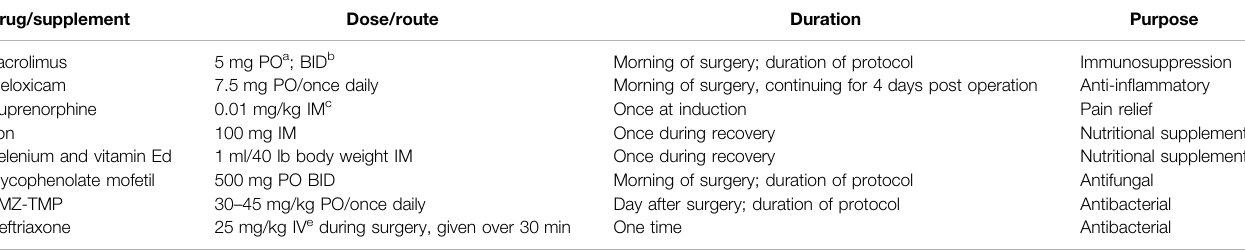
TABLE 1 | Immunosuppression and health regimen for hS/PC-implanted miniswine.